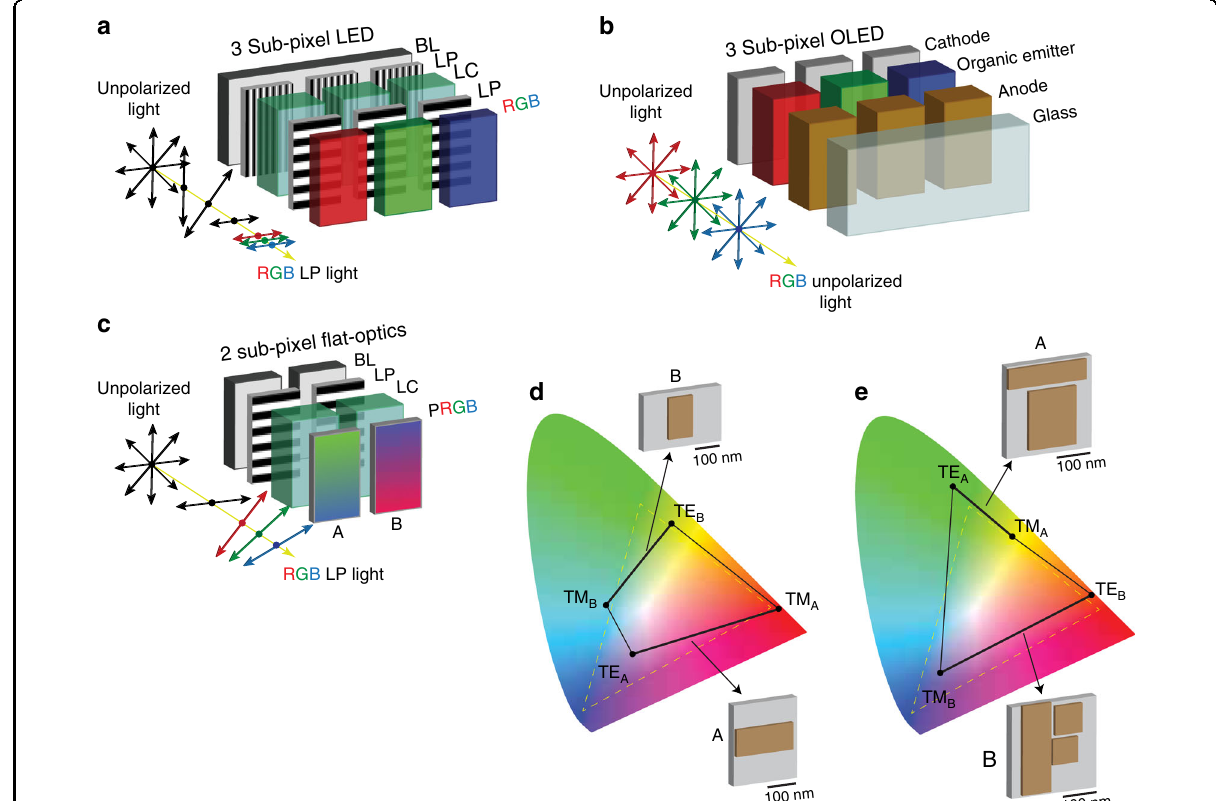
Fig. 6 Two-subpixel fl at-optics colour display: idea and design. a, b Basic working principle of current LCD/OLED colour technologies based on three red, green and blue (RGB) subpixel colour transmission units. c Proposed fl at-optics technology based on two polarization-controlled subpixels A and B. d, e ALFRED designs of A and B (3D brown boxes with grey unit cells) with the chromaticity gamut contained in ( d ) and exceeding ( e ) the standard RGB colour space (dashed yellow line). In panels d , e , the chromaticity obtained when the input light varies between TE x and TM x polarizations for samples A and B is indicated as a solid thick black line, while the total gamut obtained by mixing the two subpixels is the four-point rhomboid delimited by the black